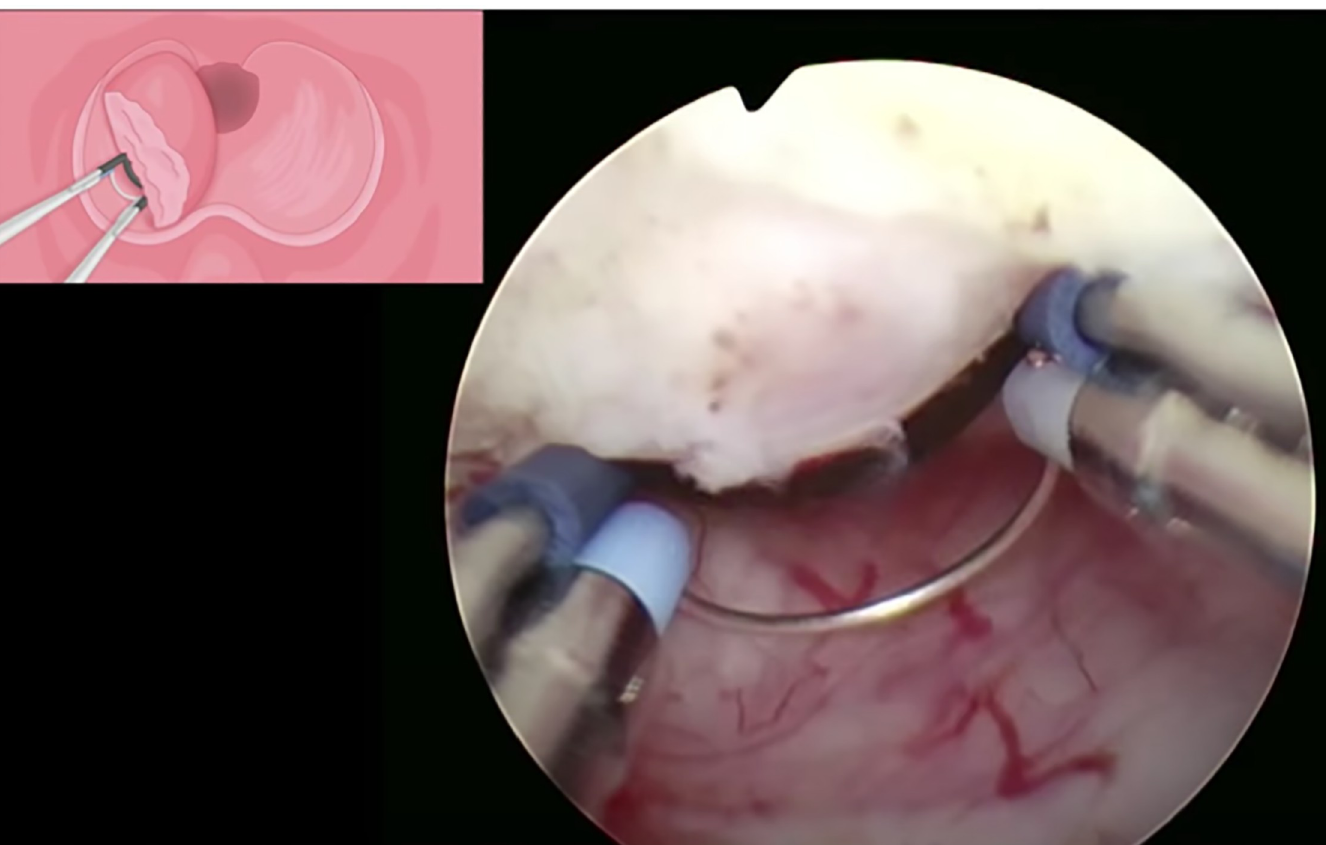
Fig 3. Next, the lateral lobes of the prostate are bluntly dissected circumferentially from the prostate apex towards the bladder following the plane of the